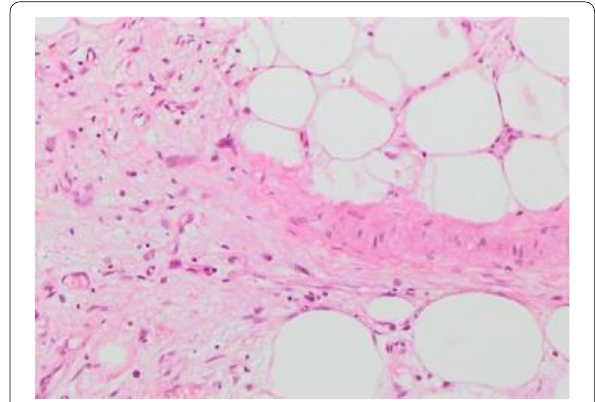
Fig. 4 Photomicrograph showing mature adipocytes intersected by fibrous septa with atypical stromal cells (haematoxylin and eosin, 200) ×